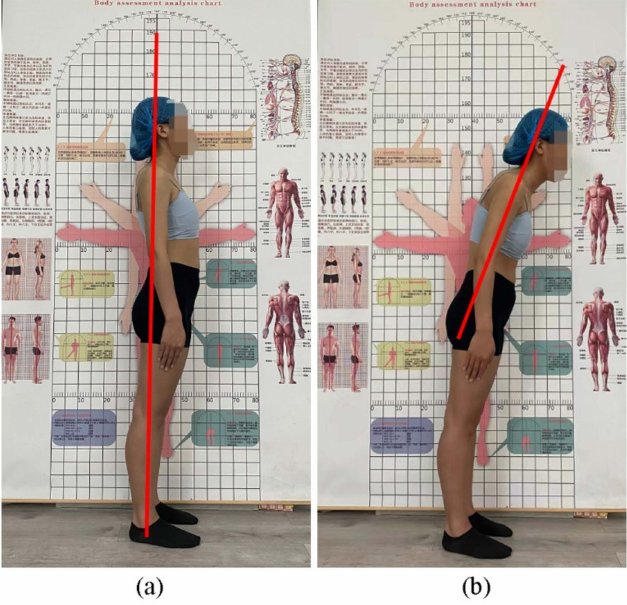
Figure 2. Posture assessment analysis. ( a ) Normal posture; ( b ) poor